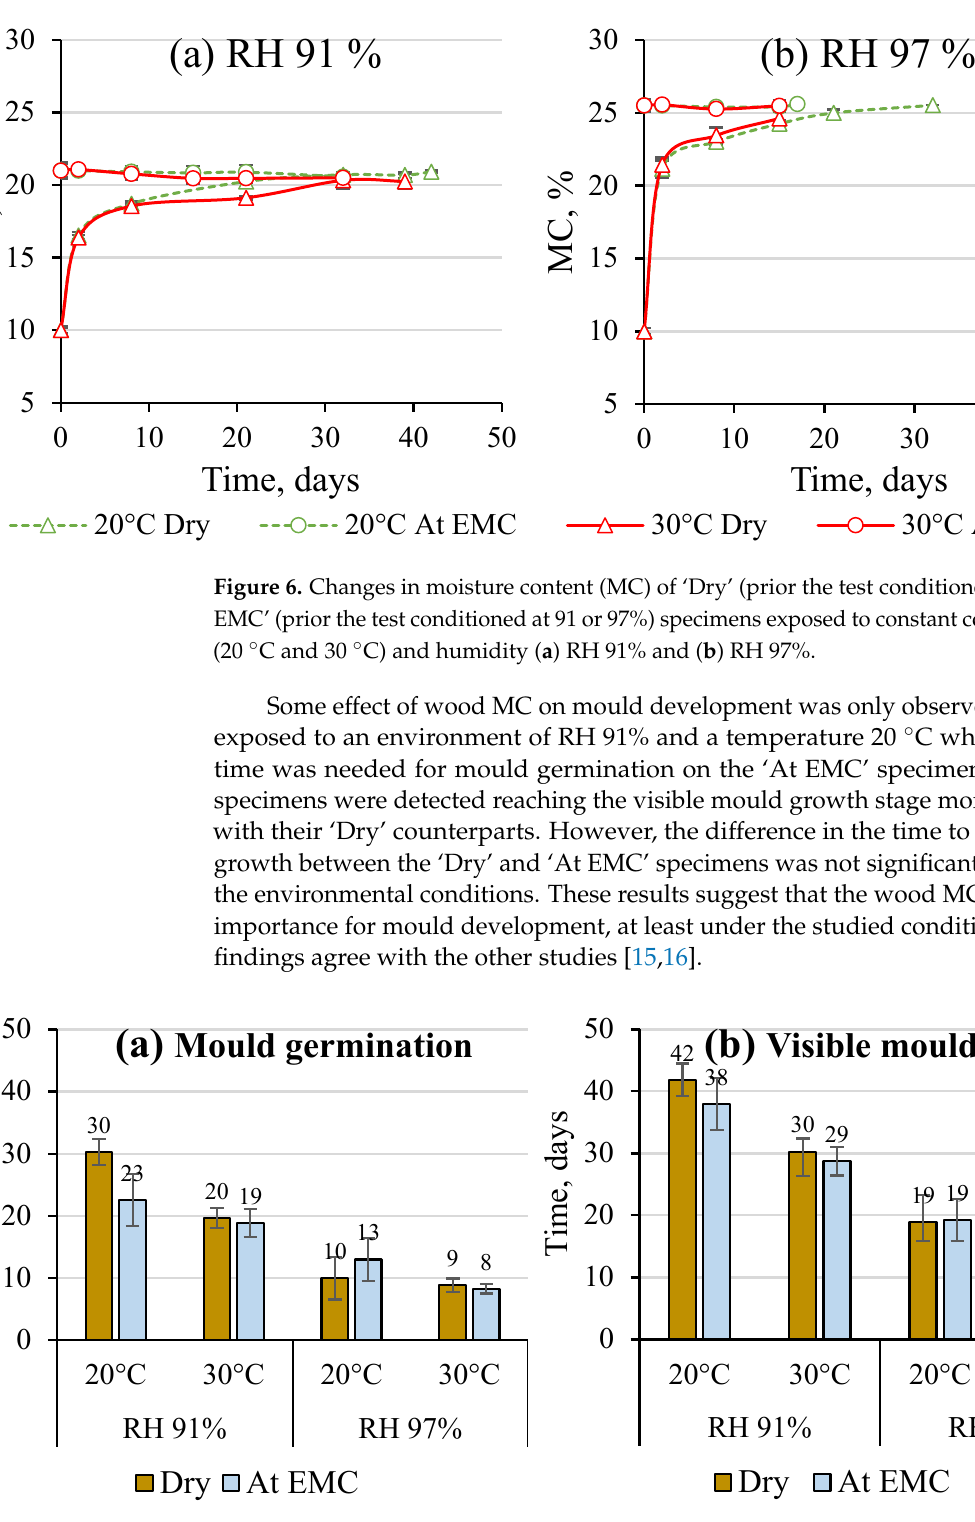
Figure 7. Time needed to reach the definite mould growth stage for ‘Dry’ (prior test conditioned at RH 50%) and ‘At EMC’ (prior test conditioned at RH 91 or 97%) specimens at different conditions; ( a ) mould germination and ( b ) visible mould